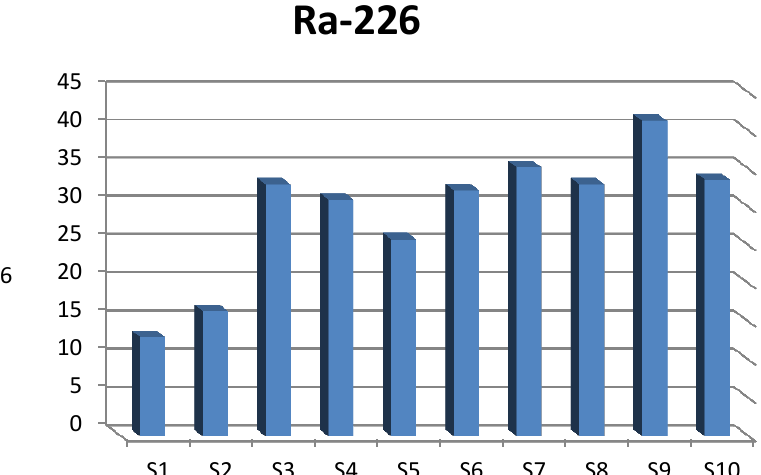
Fig.4: Radium equivalent activity in (Bq/kg) at soil samples.